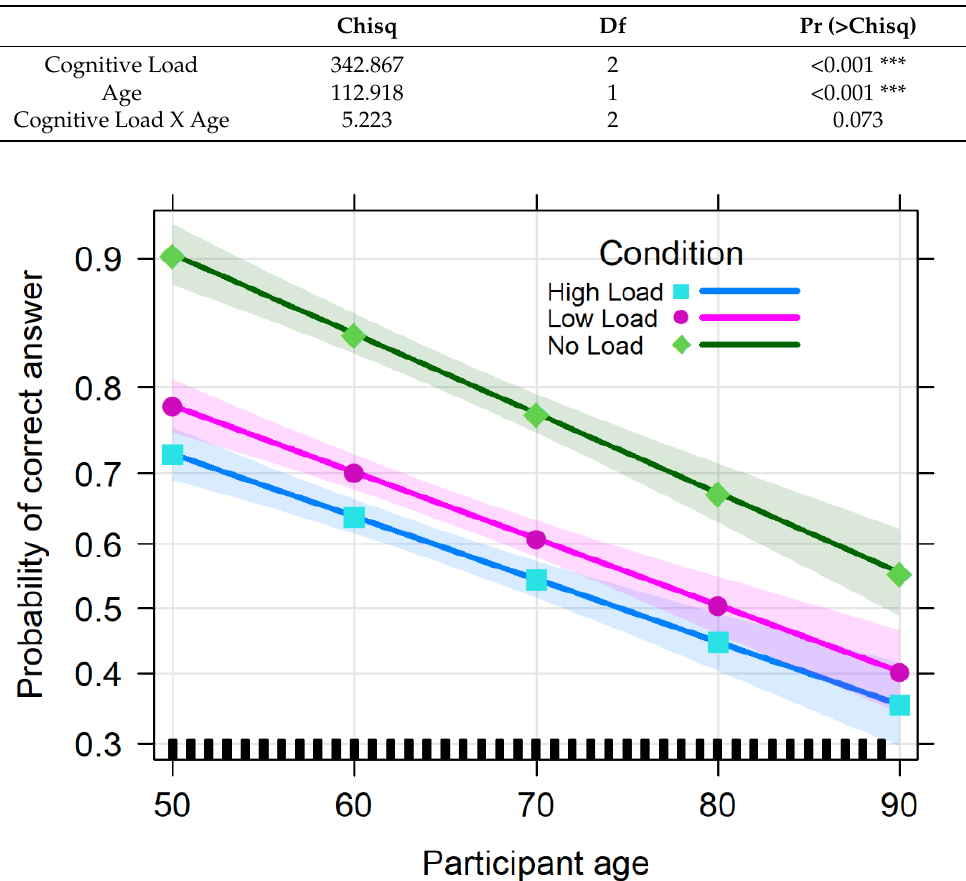
Figure 4. Performance in the memory task (memory score) as a function of Age (in years), reported separately for the three Cognitive Load conditions (No Load, LL, and HL). Bands represent 95% confidence intervals.